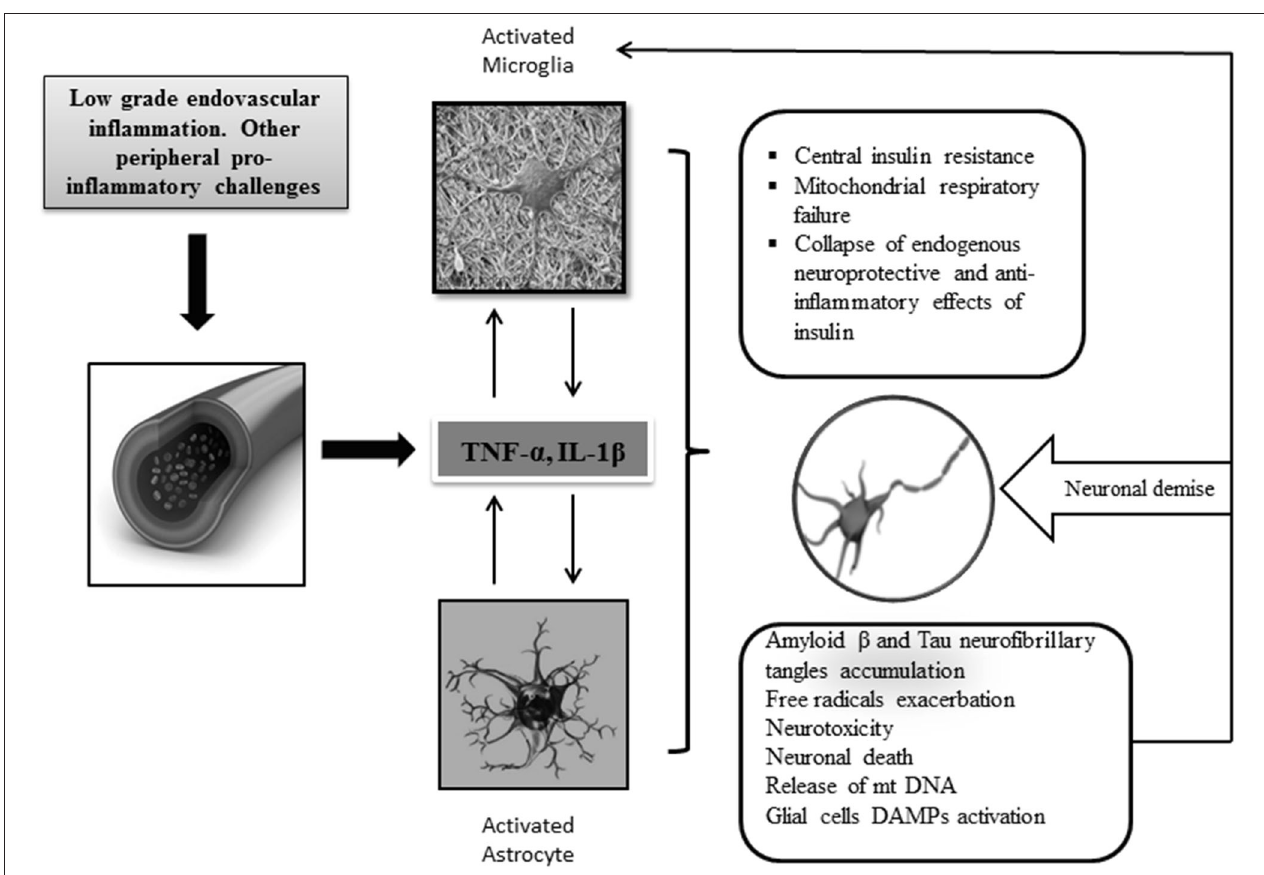
FIGURE 2 | Central neuroinflammation and consequences. Increased levels of peripheral and CNS of proinflammatory mediators support the key role of inflammation in AD pathology. Priming of glial cells to mount a protracted proinflammatory phenotype is a critical event that seems linked to aging, circulating peripheral cytokines, ROS, and neurotoxic amyloid β accumulation. Cross talk between microglia and astrocytes leads to the generation of proinflammatory/neurotoxic astrocytes, which further enhance the production of inflammatory cytokines and chemokines leading to a detrimental gliosis and astrocytosis in which, for instance, central IR and neurotoxic β amyloid accumulation are intensified. Under these conditions, mitochondrial function is further impaired, and consequently, free radicals are over-produced. Dysfunctional mitochondrial clearance is impaired. The central proinflammatory environment accounts for the amplification of this series of interrelated events eventually leading to progressive energetic collapse and neuronal and synapsis loss. The inflammatory cascade may become intensified when glial cells are further activated by the presence of released DAMP ligands, for instance, oxidized mtDNA, neuronal sequestered antigens, and accumulated β amyloid. In general, the disease is perpetuated by the interconnection of different pathogenic vicious circles, which amplify each to